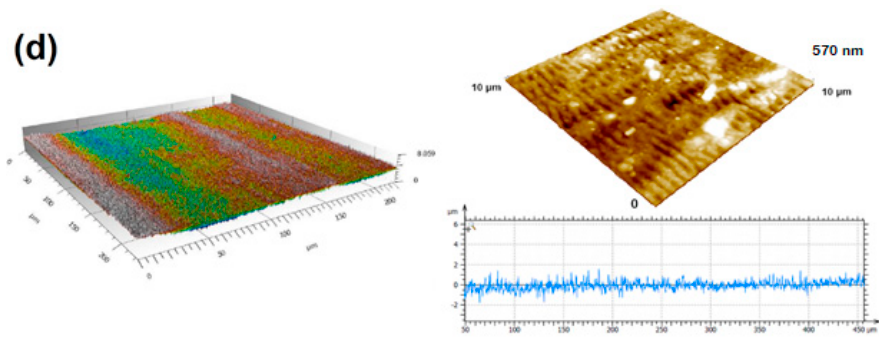
Figure 7. Images for the surface roughness using Atomic Force Microscope and Confocal Microscope. The images correspond to ( a ) black, ( b ) brown, ( c ) golden, ( d ) multicolor. The roughness histograms shown on the right side of the Figure were generated from the Confocal Microscope measurements.